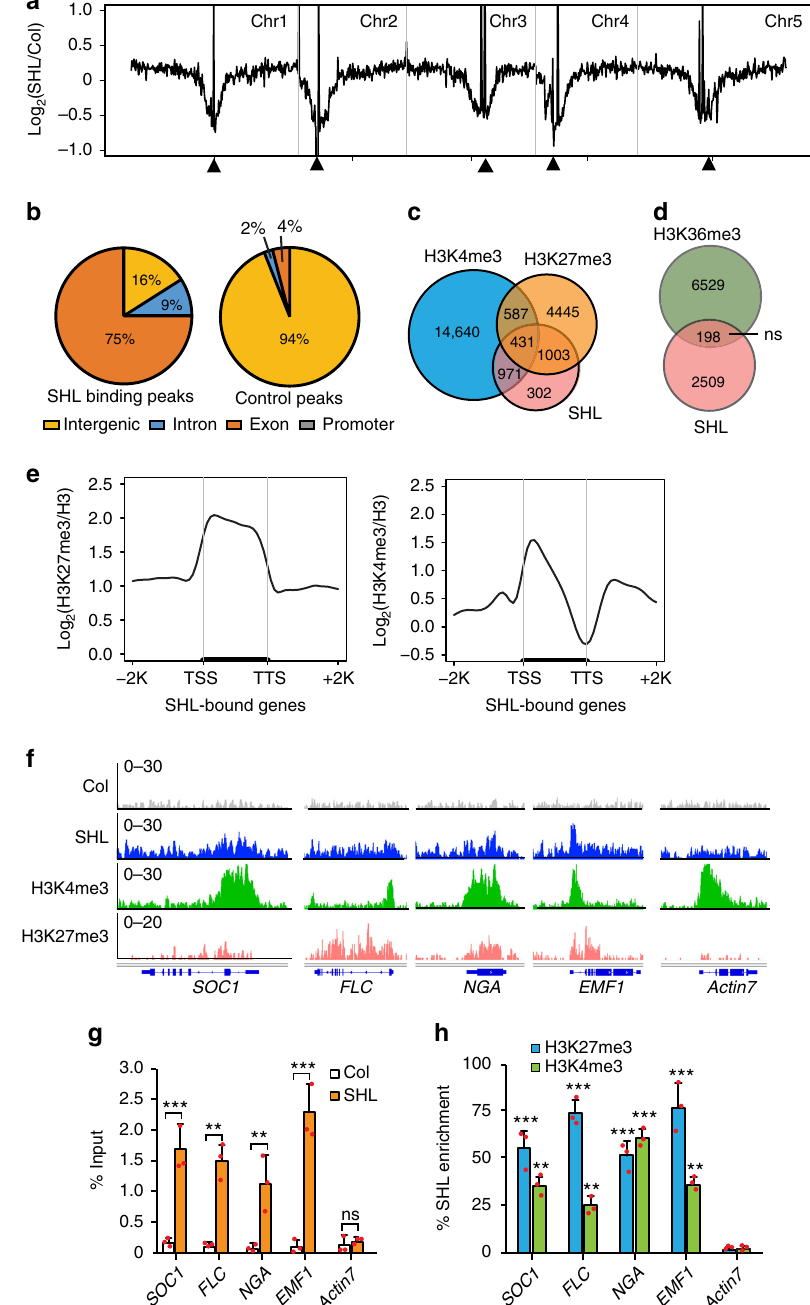
Fig. 5 SHL co-localizes with H3K4me3 and H3K27me3 in the genome. a Chromosomal views show that SHL is highly enriched in gene-rich euchromatic regions. Y -axis represents the Log 2 value of ChIP-seq reads normalized to wild-type Col. The Chr1, Chr2, Chr3, Chr4, and Chr5 represent the fi ve Arabidopsis chromosomes. Black triangle indicates the location of the centromere. b Genomic distribution of SHL ChIP-seq peaks. Control peaks are the same numbers of regions as SHL-bound peaks randomly selected from the genome. c Venn diagram showing the overlap of SHL-, H3K4me3-, and H3K27me3-enriched genes. d Venn diagram showing the overlap of SHL-bound genes with H3K36me3-marked genes. The P value is based on the hypergeometric test. ns, not signi fi cant. e Metaplots of H3K27me3 and H3K4me3 levels over the transcription unit of SHL-bound genes. Y -axis represents the levels of histone modi fi cations normalized with H3. TSS, transcription start site; TTS, transcription termination site; -2K, 2kb upstream of TSS; + 2K, 2kb downstream of TTS. f Genome-browser view of normalized ChIP-seq peaks at representative loci. g Relative enrichment of SHL at the indicated loci in ( f ) calculated as the percent of input materials. h Sequential ChIP-qPCR showing the H3K4me3 and H3K27me3 enrichment relative to SHL at the indicated loci in ( f ). Actin7 serves as a control locus. All error bars represent mean ± SD from three independent experiments. Red dots denote the individual data points. Student ’ s t -test was used to calculated the P value. * P < 0.05; ** P < 0.01; *** P < 0.001; ns, not signi fi